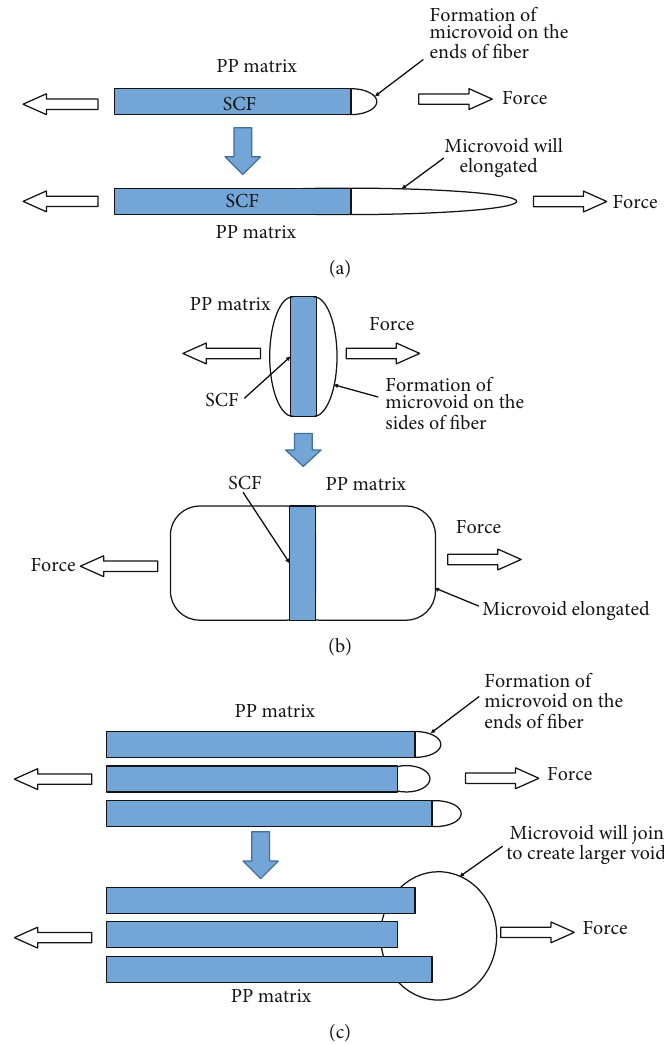
Figure 11: Formation of microvoids on (a) single SCF oriented parallel to the force, (b) single SCF oriented perpendicular to the force, and (c) agglomerate SCF oriented parallel to the force.